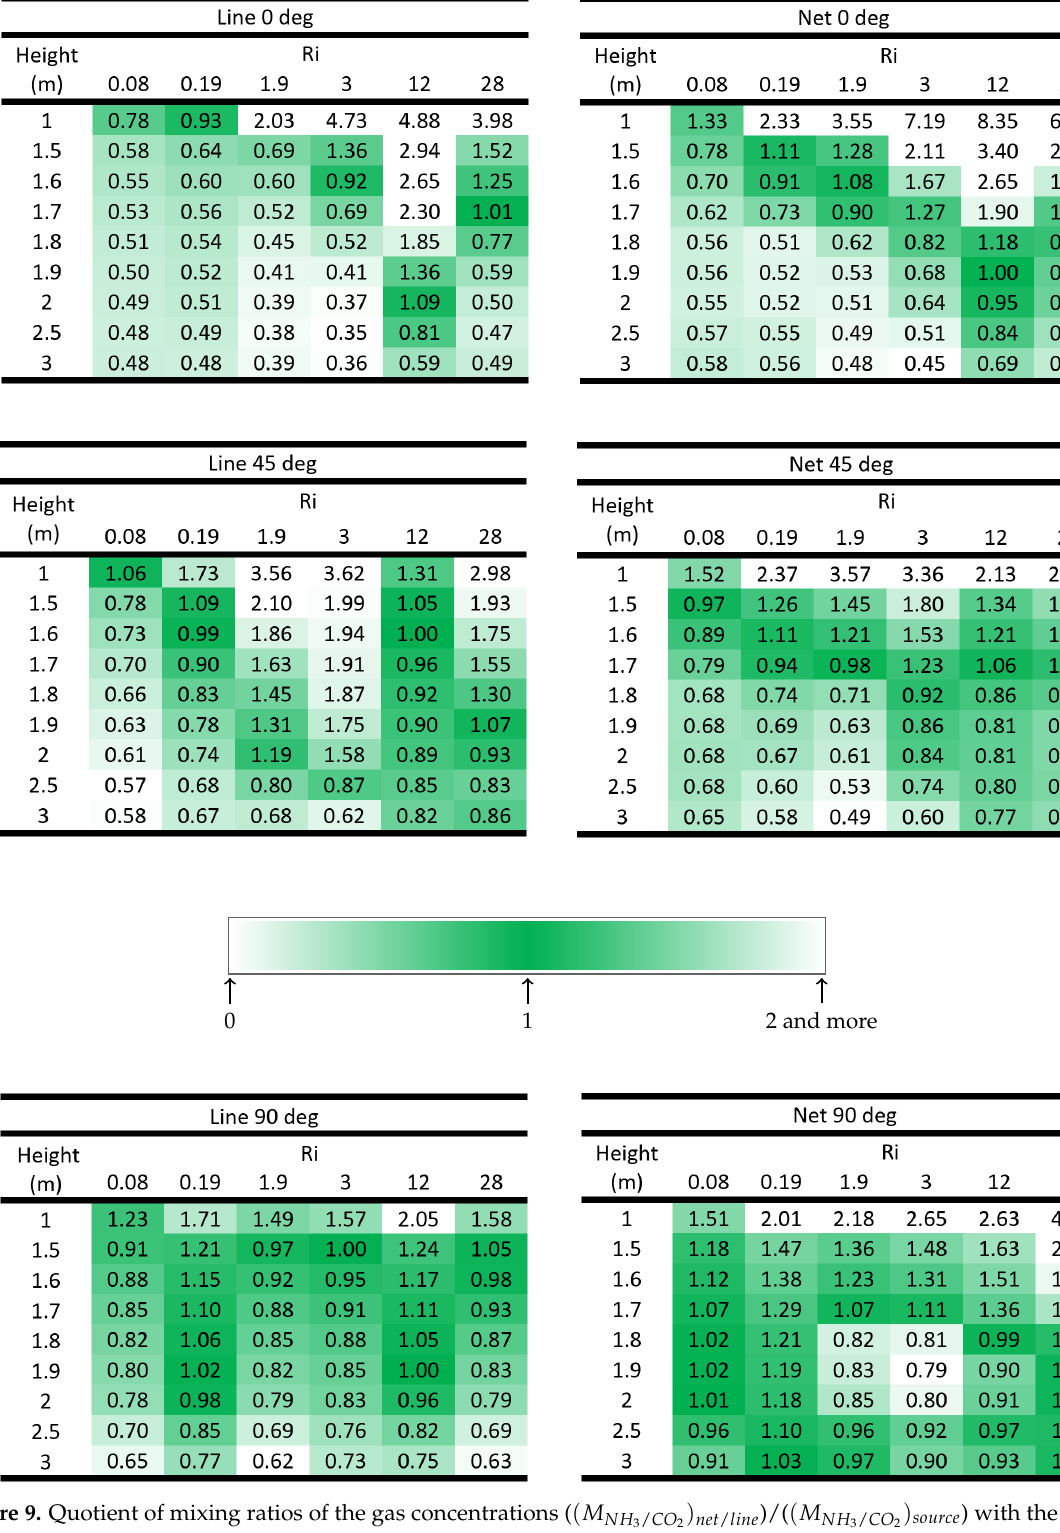
Figure 9. Quotient of mixing ratios of the gas concentrations ( ( M NH net at different heights, for diverse values of the Richardson numbers and for the 3 incoming flow